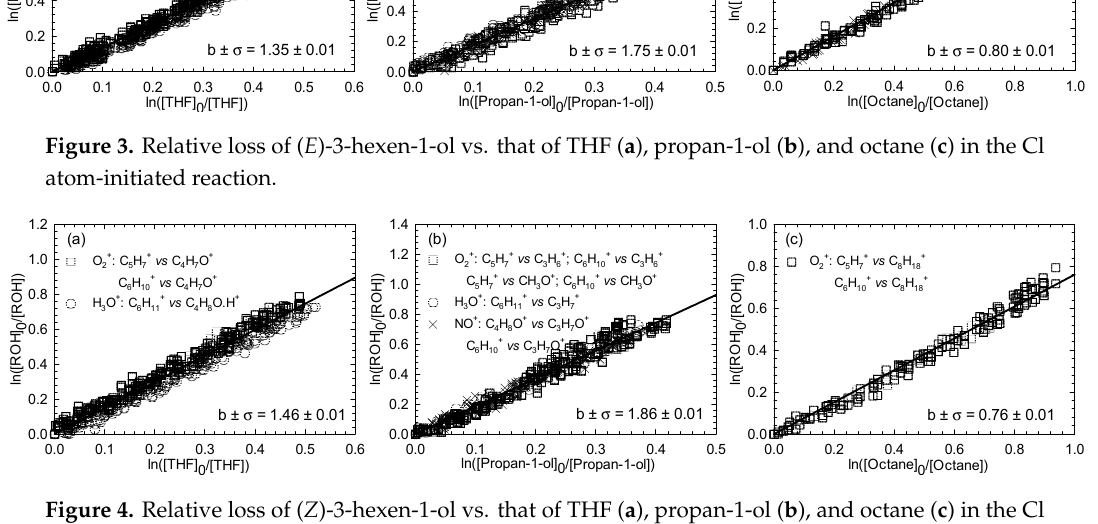
Figure 4. Relative loss of ( Z )-3-hexen-1-ol vs. that of THF ( a ), propan-1-ol ( b ), and octane ( c ) in the Cl atom-initiated reaction.